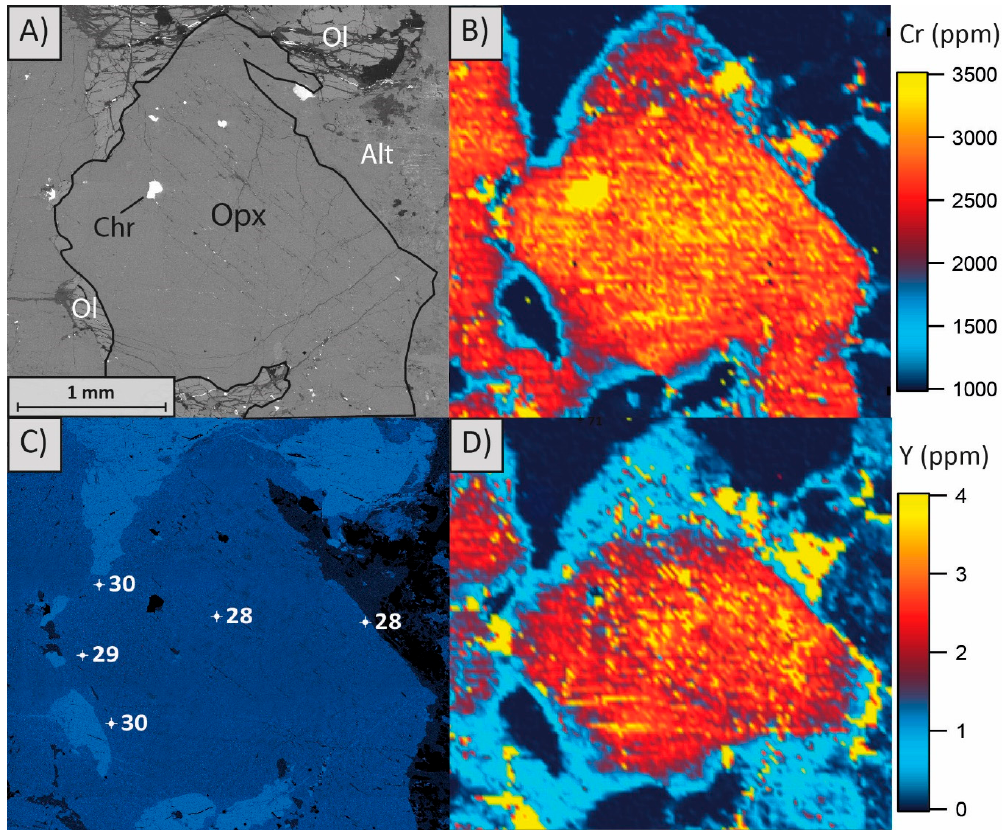
Figure 6. ( A ) Backscattered electron image of Upper Pegmatoid, sample 309.75a. Chr (chromite), Opx (orthopyroxene), Ol (olivine), Alt (secondary alteration phases); ( B ) Semi-quantitative Cr distribution map, obtained by LA-ICP-MS; ( C ) Magnesium distribution map obtained by SEM-EDX. White numbers represent MgO wt. % concentration in orthopyroxene; ( D ) Semi-quantitative Y distribution map, obtained by